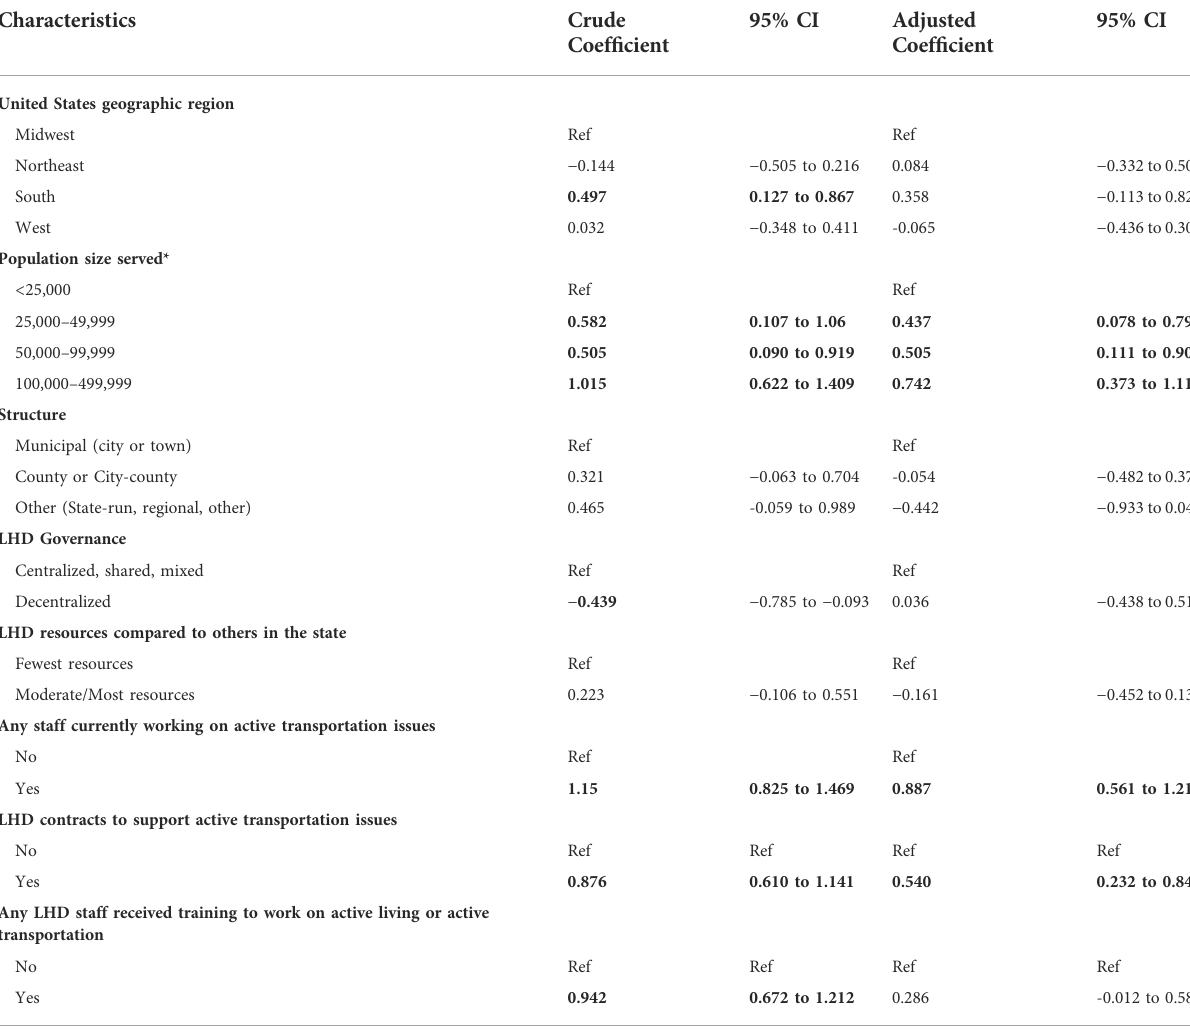
TABLE 2 Results from crude and multivariable negative binomial regression of factors associated with LHD engagement in active transportation activities (unweighted n = 183, weighted n = 2 390).